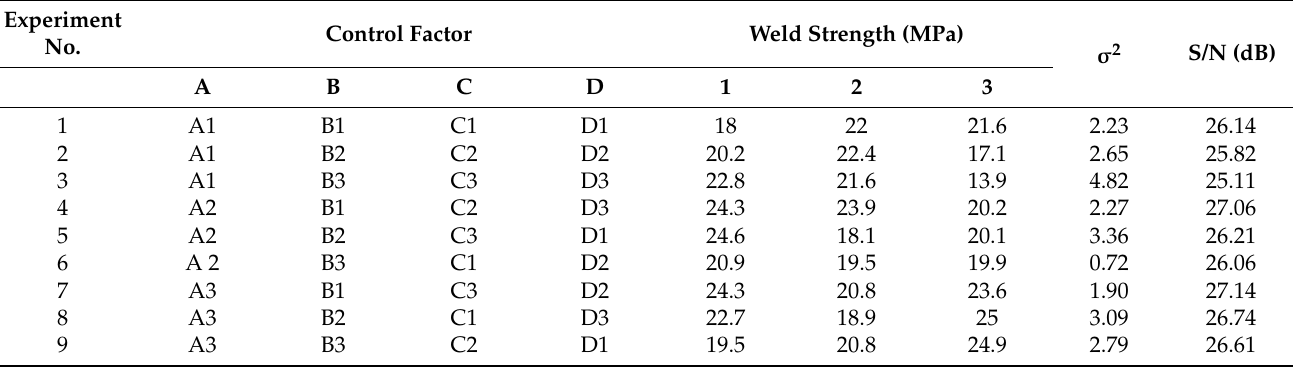
Table 3. Response table of S/N ratio based on the-larger-the-better quality